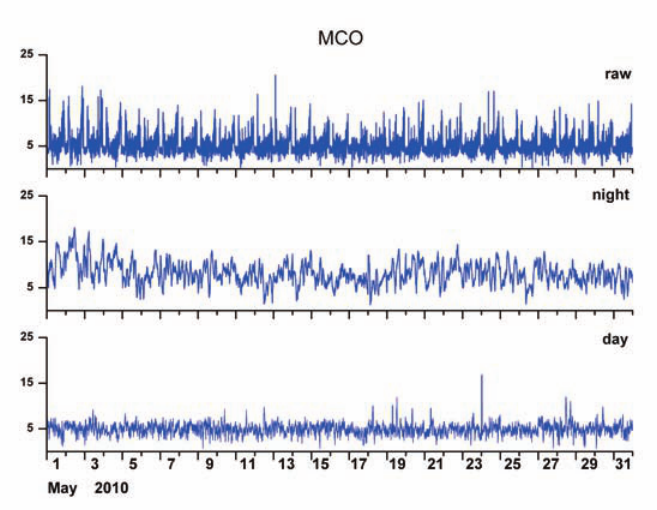
Figure 2. Night-time and day-time MCO transmitter radio signals collected by the IT-An receiver in May 2010. Top panel: Intensity of the raw MCO (216 kHz) transmitter signals. Middle panel: Night-time (20.00- 22.00 UT) data extracted from the raw data. Bottom panel: Day-time (08.00-13.00 UT) data extracted from the raw data.